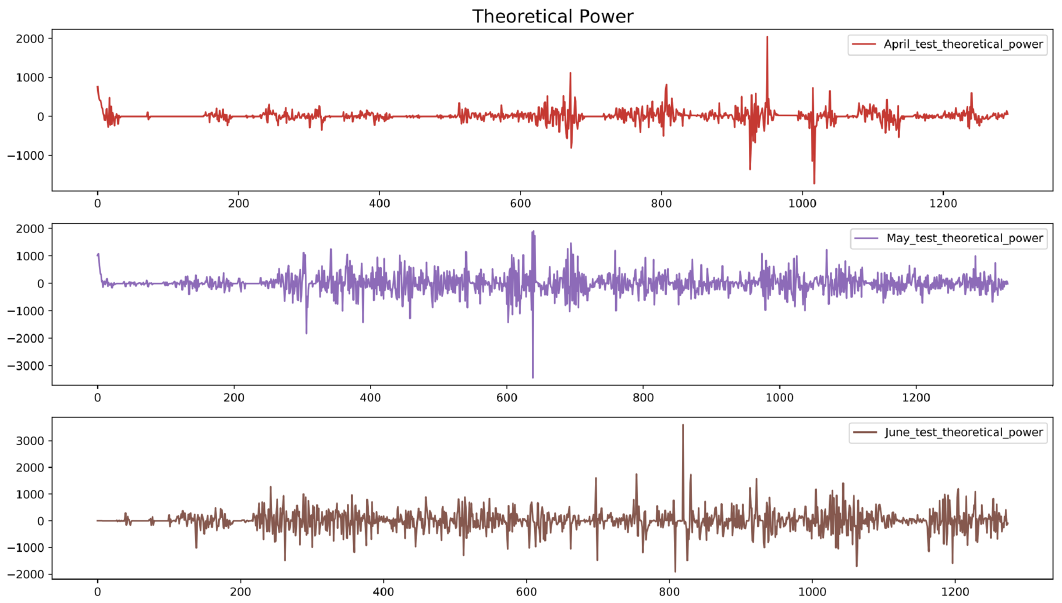
Figure 21. The difference between the actual and predicted value of theoretical power over the test set of April, May, and June.